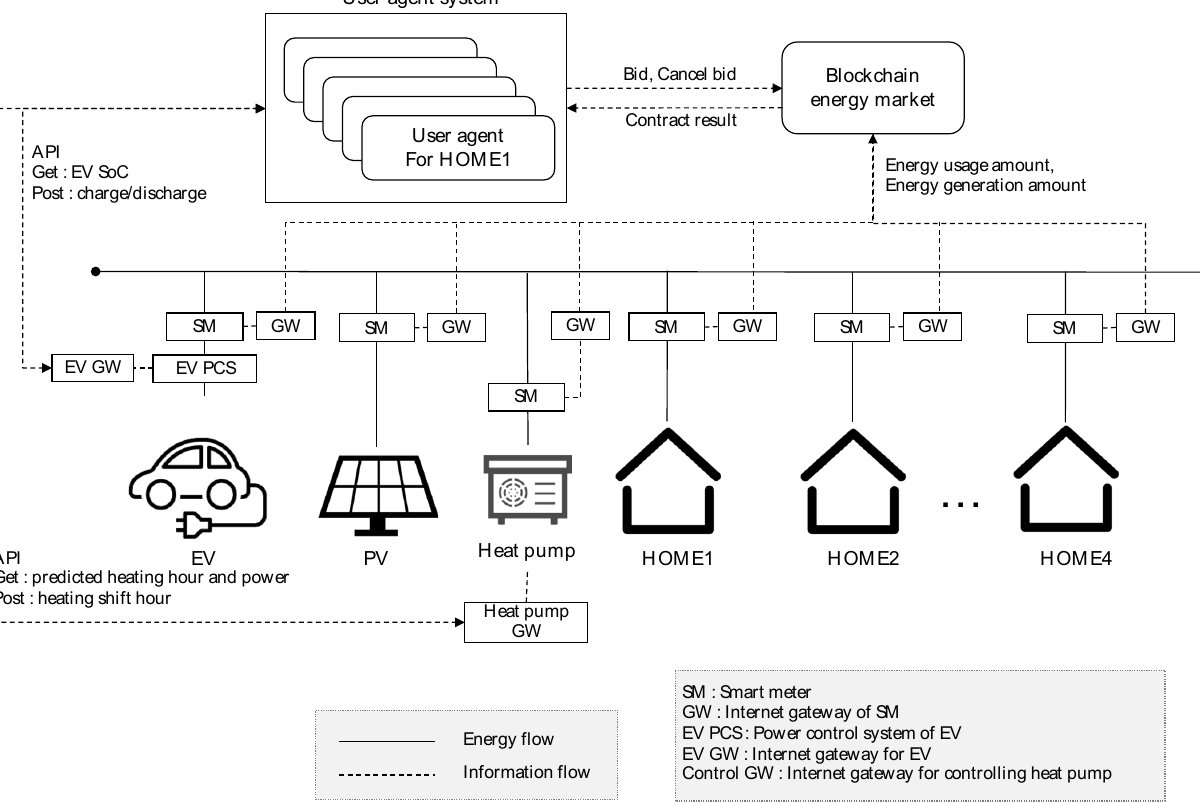
Figure 1. Diagram of demonstration experiment.